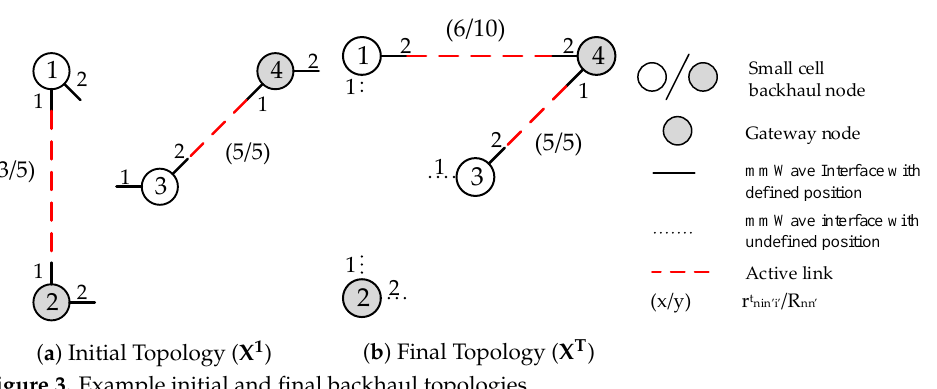
Figure 3. Example initial and final backhaul